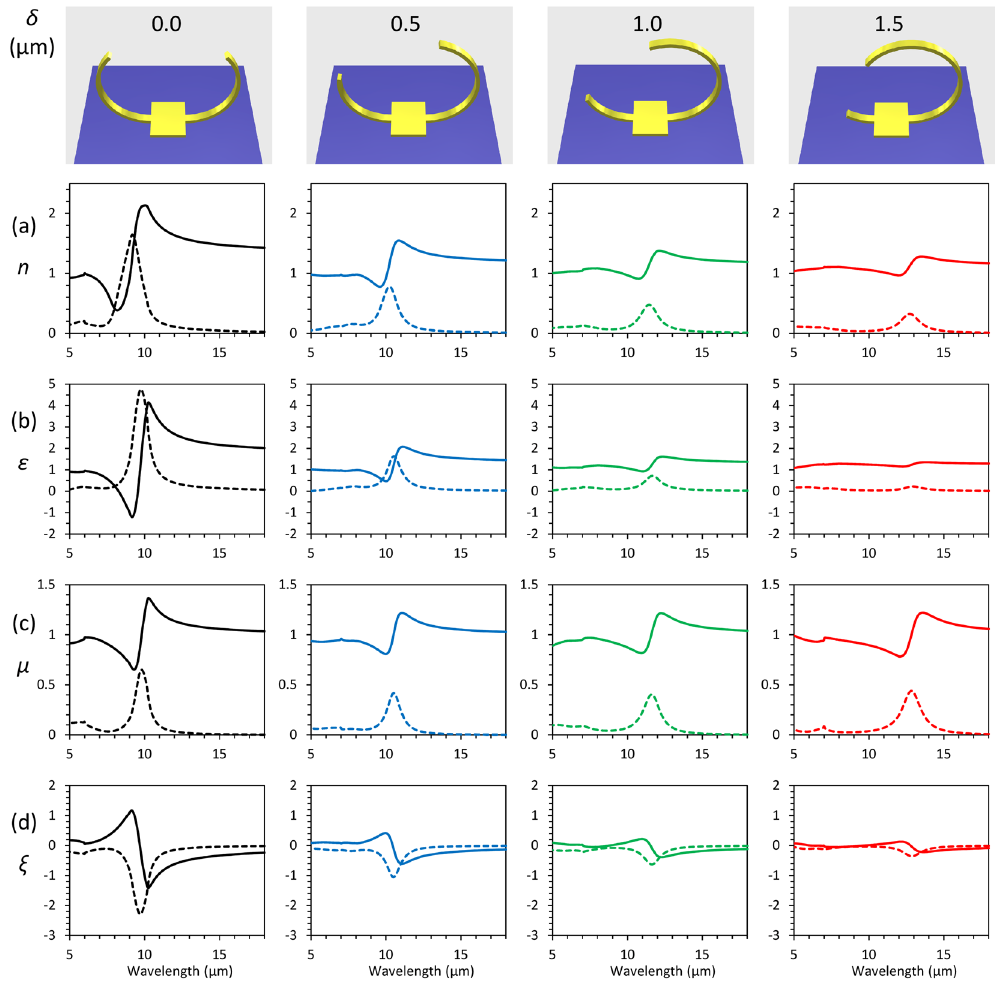
Figure 5. Retrieved effective parameters for 3D-SRRs on a Si substrate for respective δ . ( a ) Refractive index ( n ), ( b ) relative permittivity ( ε ) , ( c ) relative permeability ( μ ) , and ( d ) bi-anisotropic parameter ( ξ ) for different δ . Solid and dashed lines correspond to real and imaginary parts of effective parameters,